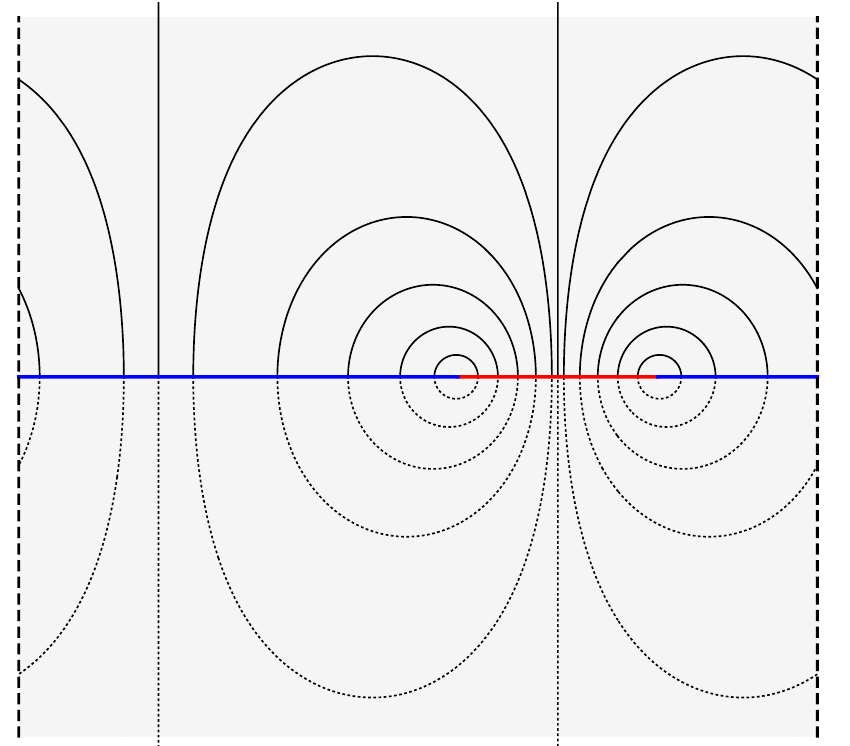
Figure 14 . Euclidean modular evolution for a CFT in the ground state and on the circle bipartite by an interval (the dashed vertical line are identified). The curves are obtained from (A.4) for some x ∈ A , with either θ ∈ (0 , π ) (solid arcs) or θ ∈ ( π, 2 π ) (dotted arcs). They map a point in A to a point in its complement on the circle (and viceversa), related by